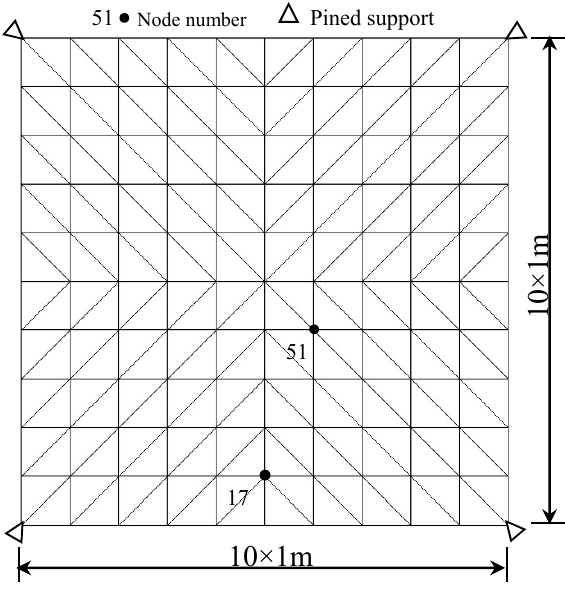
Figure 1. The initial structure and constraints.